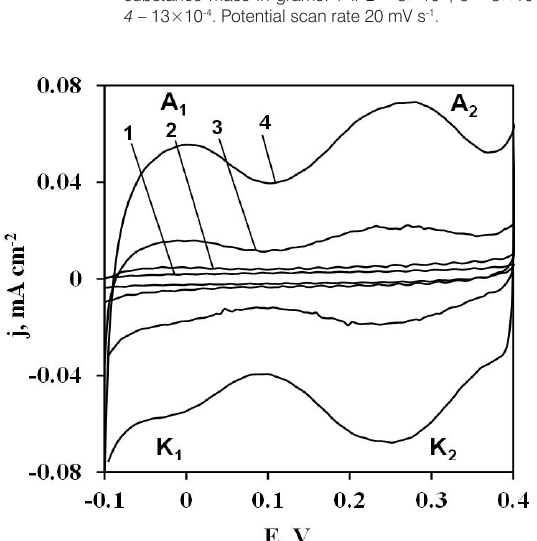
Figure 5. Cyclic voltammograms of Co(OH) steel in 0.1 M NaOH solution with the different active